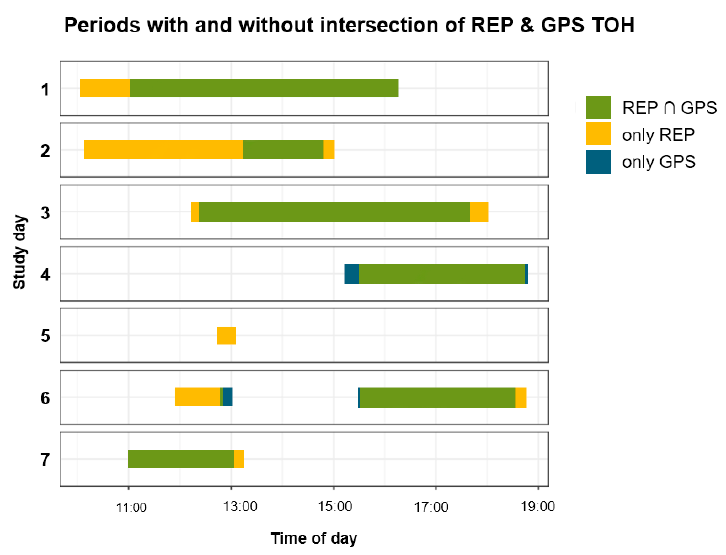
Figure A3. Identification of IoU based on one week of TOH data of one participant (same participant